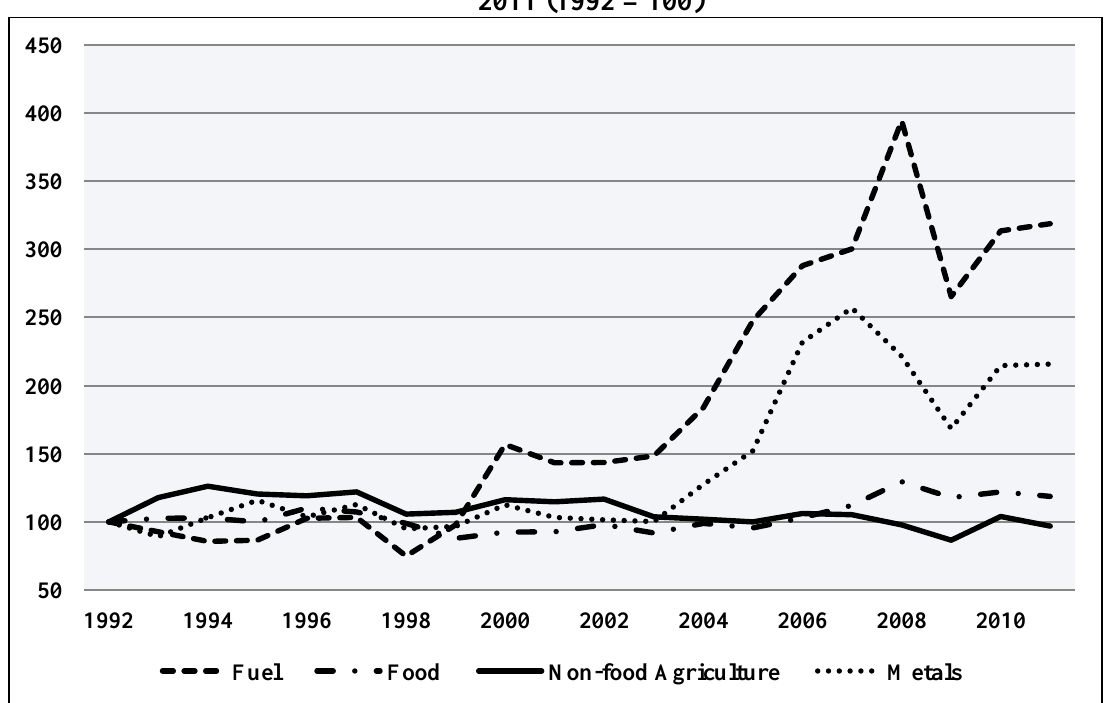
Figure 4: Recent Terms of Trade for Fuel, Food, Non-food Agriculture and Metals 1992